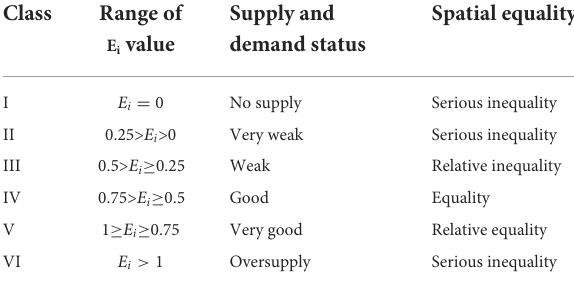
TABLE 1 List of dependent variables.